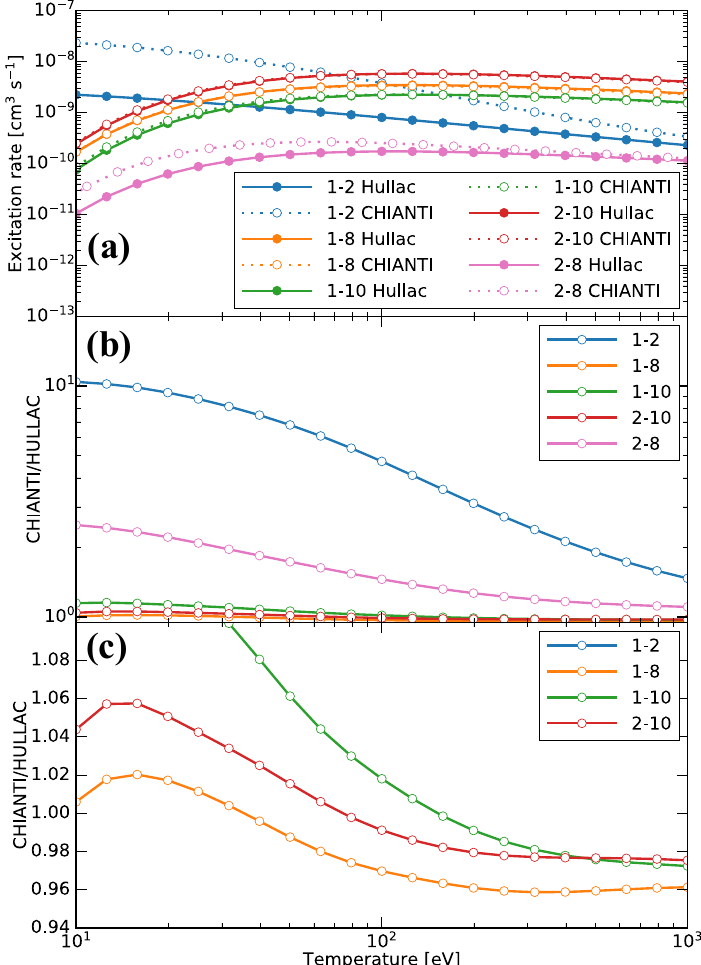
Figure 12. ( a ) Electron excitation rate coefficients for our model and CHIANTI. Number denotes levels: 1 denotes 3 s 2 3 p 2 P ◦ , 2 denotes 3 s 2 3 p 2 P ◦ , 8 denotes 3 s 3 p 2 2 S 1/2 , and 10 denotes 1/2 3/2 3 s 3 p 2 2 P 3/2 . ( b ) CHIANTI results divided by our results on logarithmic scale. ( c ) CHIANTI results divided by our results on linear